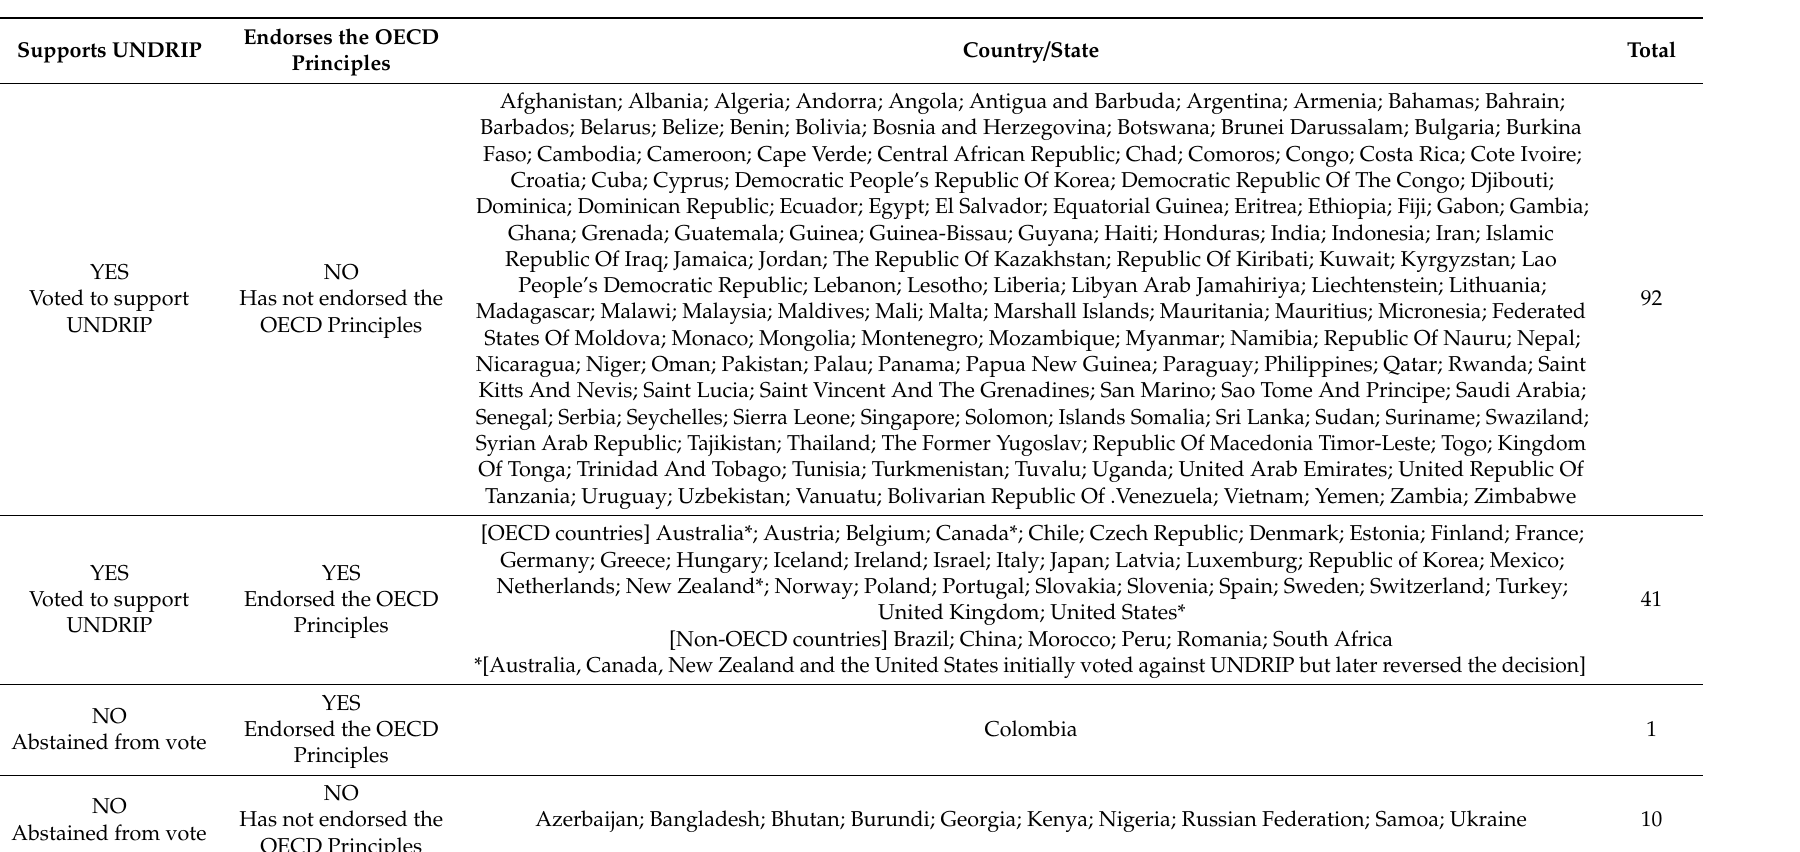
Table A1. UNDRIP signatories and countries endorsing the OECD